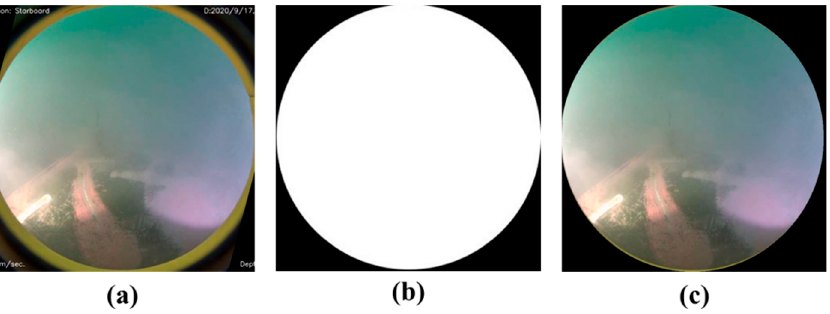
Figure 3. ( a ) Camera image of size 512 × 512, ( b ) mask image, and ( c ) final image used for training.